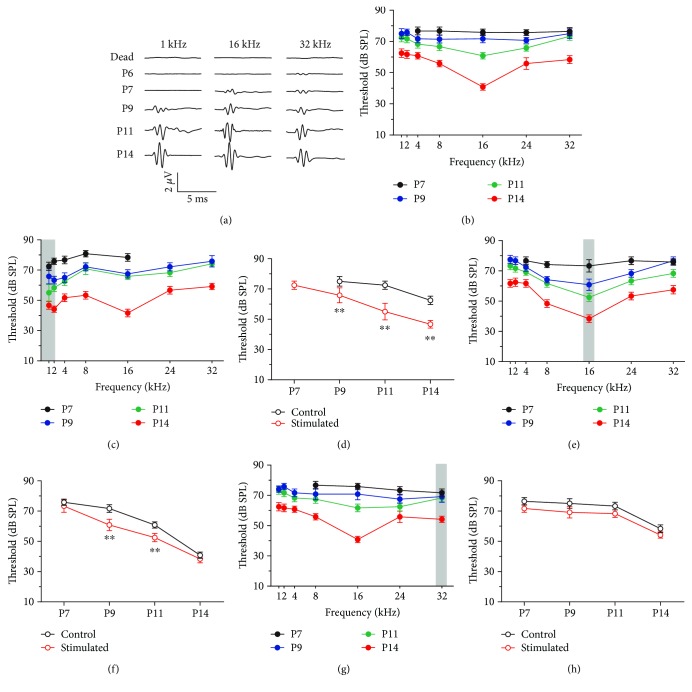
Effects of acoustic stimulation on ABR responses at different postnatal ages. (a) Representative ABR waveforms in response to 1 kHz, 16 kHz, and 32 kHz tone bursts (80 dB SPL) at different postnatal ages. The traces recorded from dead animals show that no stimulation artifact was observed. (b) The ABR threshold frequency-tuning curves at different postnatal ages (P7, N = 7; P9, N = 7; P11, N = 6; P14, N = 6). The color code in (b) applies for (c), (e), and (g). (c) The ABR threshold frequency-tuning curves at different postnatal ages after low-frequency sound environment stimulation. The grey area indicates the stimulation frequency used for the sound environment (P7, N = 6; P9, N = 7; P11, N = 6; P14, N = 6). (d) The changes in ABR threshold in response to a 1 kHz tone burst during postnatal development for those animals in (c) (red) and control animals in (b) (black). (e) The ABR threshold frequency-tuning curves at different postnatal ages after 16 kHz sound environment stimulation (P7, N = 6; P9, N = 6; P11, N = 6; P14, N = 6). (f) The changes in ABR threshold in response to a 16 kHz tone burst during postnatal development for those animals in (e) (red) and control animals in (b) (black). (g) The ABR threshold frequency-tuning curves at different postnatal ages after 32 kHz sound environment stimulation (P7, N = 6; P9, N = 6; P11, N = 6; P14, N = 6). (h) The changes in ABR threshold in response to a 32 kHz tone burst during postnatal development for those animals in (g) (red) and control animals in (b) (black). All data points represent the mean ± standard deviation. ∗∗p < 0.01. ABR: auditory brainstem response; N: number; P: postnatal day.